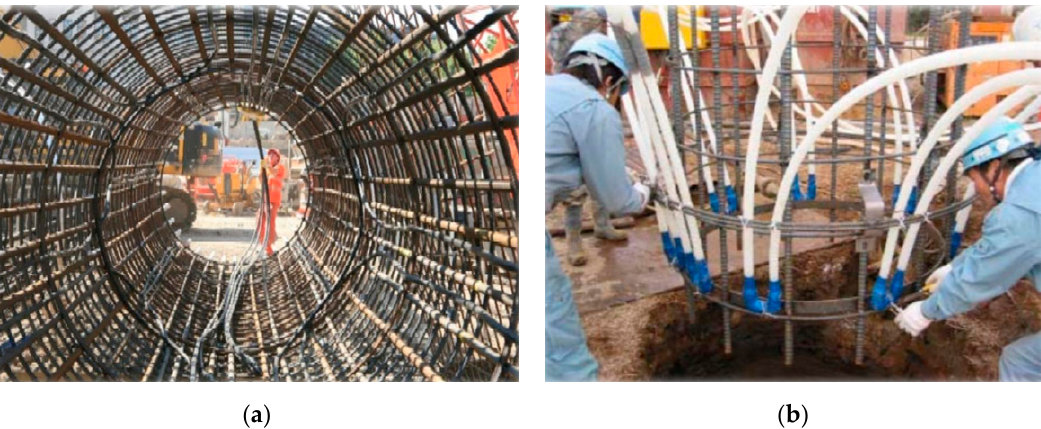
Figure 3. ( a ) The reinforcement of the energy pile, ( b ) the insertion of the reinforcement in the form of a basket equipped with a U-tube system into the borehole [52].